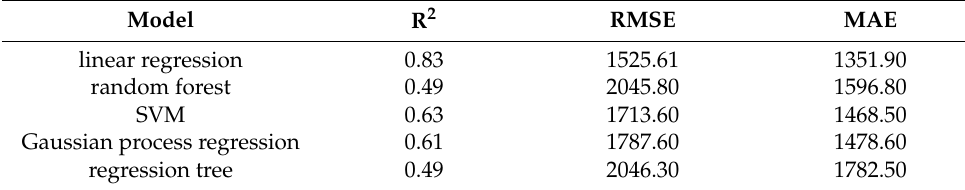
Table 4. The regression accuracy of the GDP model of the secondary industry. Model